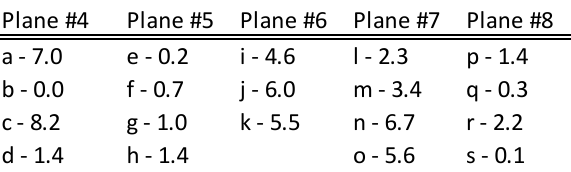
Table 5. Plane fitting differences at corners a-s of building 2 of Figure 6.